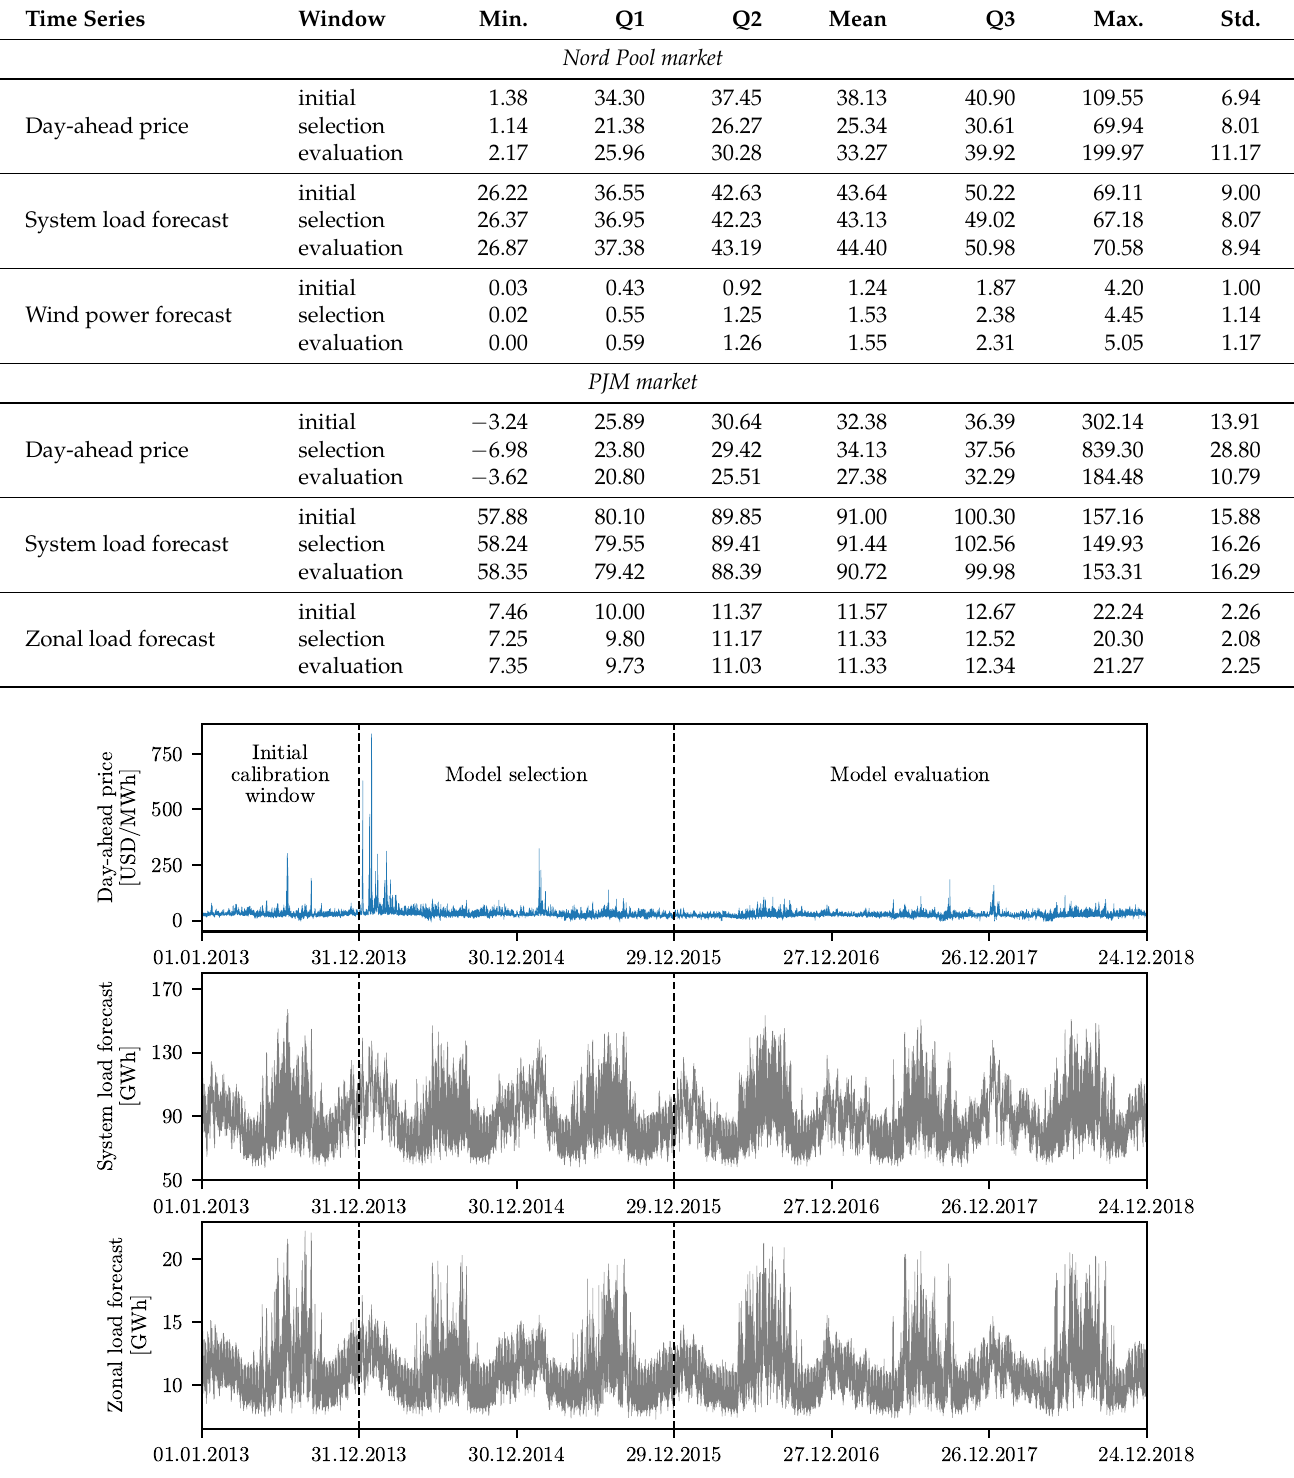
Table 1. The summary statistics for the considered time series: the minimum value, the 1st quartile (Q1), the 2nd quartile (Q2; i.e., the median), the mean, the 3rd quartile (Q3), the maximum value, and the standard deviation. For each series, three rows report values in the initial calibration window ( top ), the model selection window ( middle ), and the model evaluation window ( bottom ).